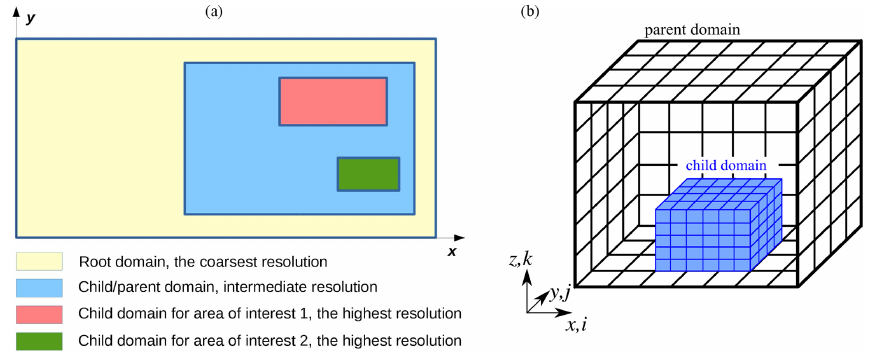
Figure 1. A schematic example of a nested configuration involving both cascading and parallel child domains is shown on x – y plane on the left-hand side. On the right-hand side, a three-dimensional view of a nested child domain inside its parent domain is